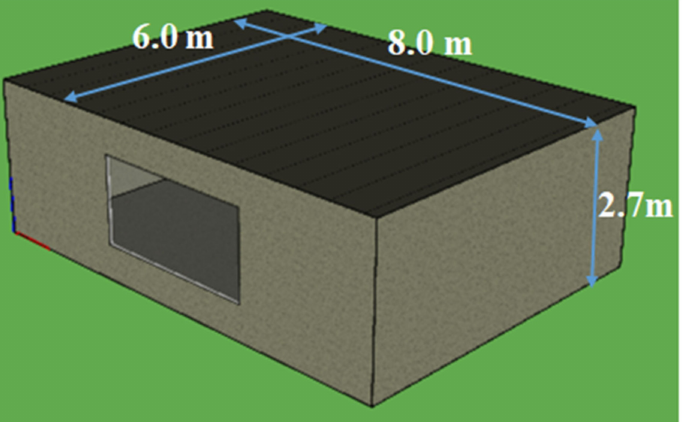
Figure 2. The modelled building in IDA-Indoor Climate and Energy